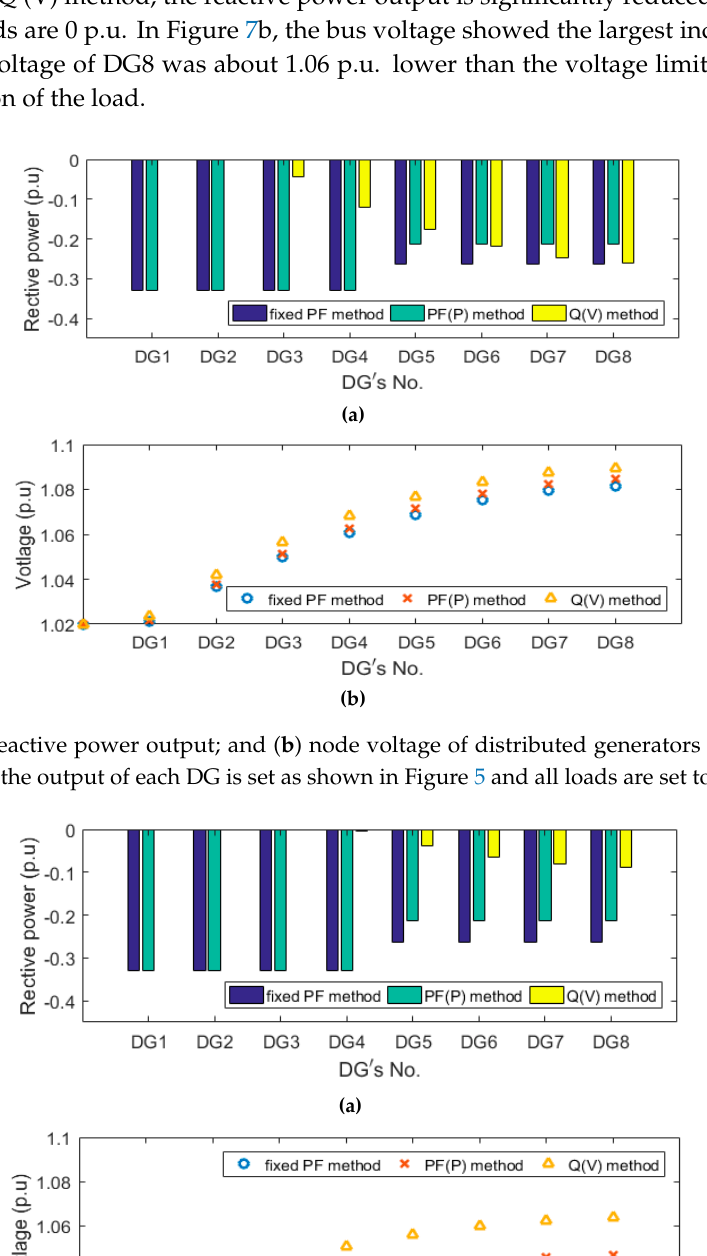
Figure 4. Active power output of DGs.